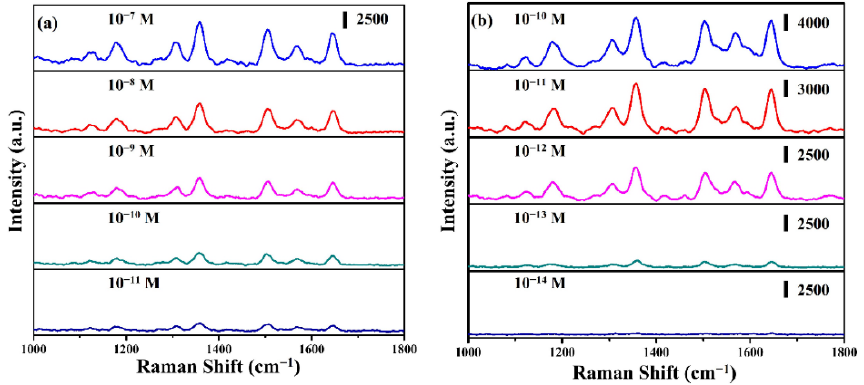
Figure 7. SERS spectra of R6G solution at different concentrations were obtained from ( a )